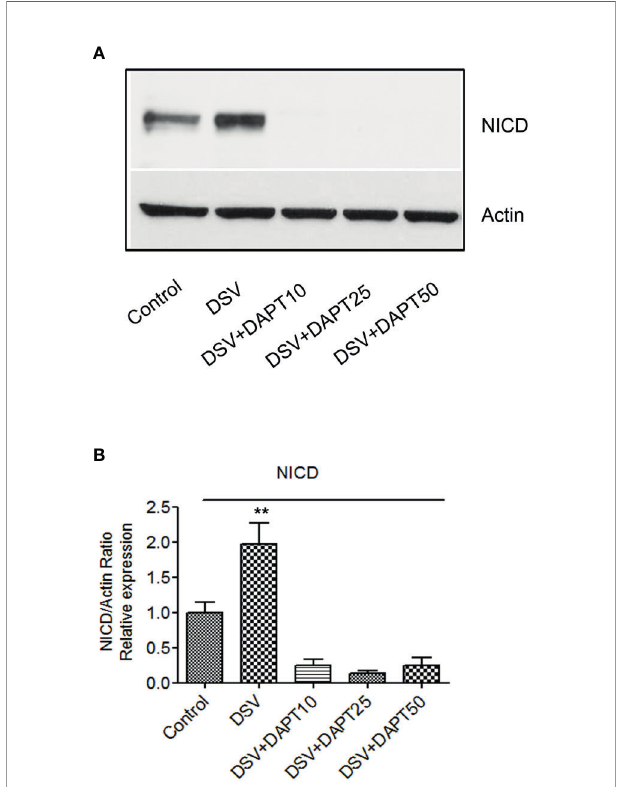
FIGURE 8 | DSV induces Notch activation in epithelial cells (A) HCT116 cells (8x10 5 ) were infected with DSV at MOI 20 for 7 hours. Cells were lysed and protein lysate was prepared. Fifty m g of protein lysate was separated on SDS- PAGE and analyzed for NICD and Actin by Western blotting. (B) Quanti fi cation of Western blots. Blots were quanti fi ed with ImageJ by analyzing the ratio of NICD/Actin. Data represents Mean ± SEM from at least three independent experiments. Values were normalized to control. **p <